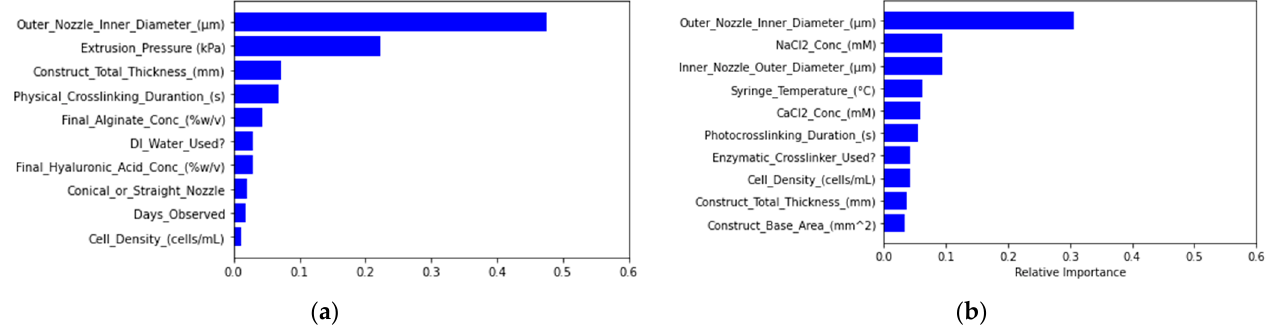
Figure 6. Feature importance rankings of material, equipment, and experimental parameters based on ( a ) random forest regression and ( b ) random forest classification modeling of filament diameter.